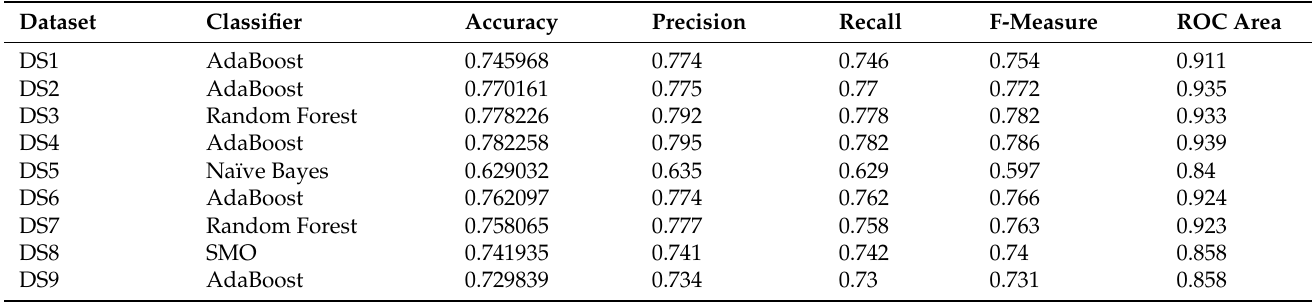
Table 8. Best classifier for each dataset according to F-measure.